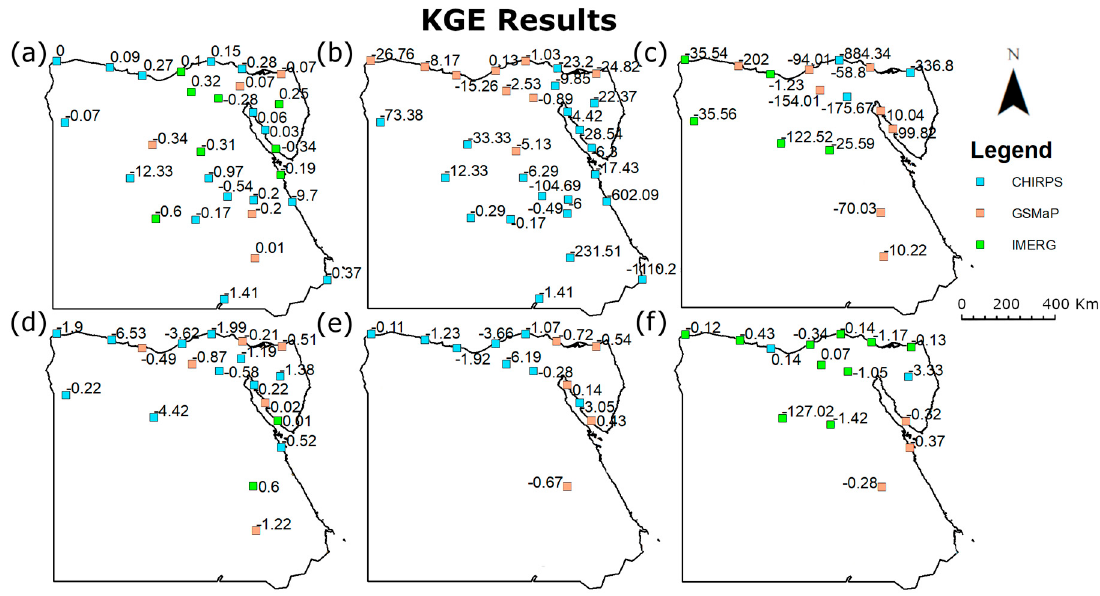
Figure 7. Maps showing the best performing datasets according to KGE at each station along with the estimated KGE for best performing satellite rainfall product for ( a ) all rainfall events, ( b ) no/tiny rain, ( c ) light rain, ( d ) low–moderate rain, ( e ) heavy–moderate rain, and ( f ) heavy rain .